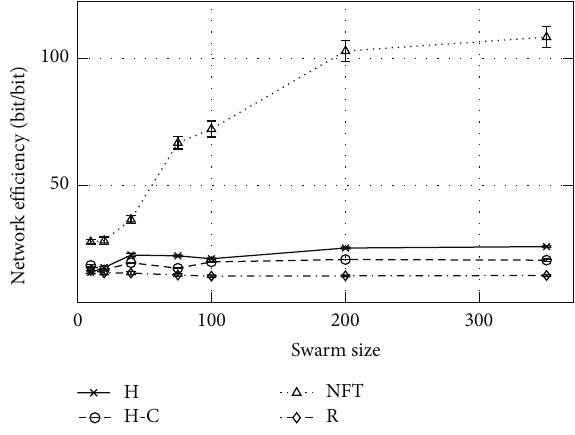
Figure 10: Average network efficiency in Scenario I.